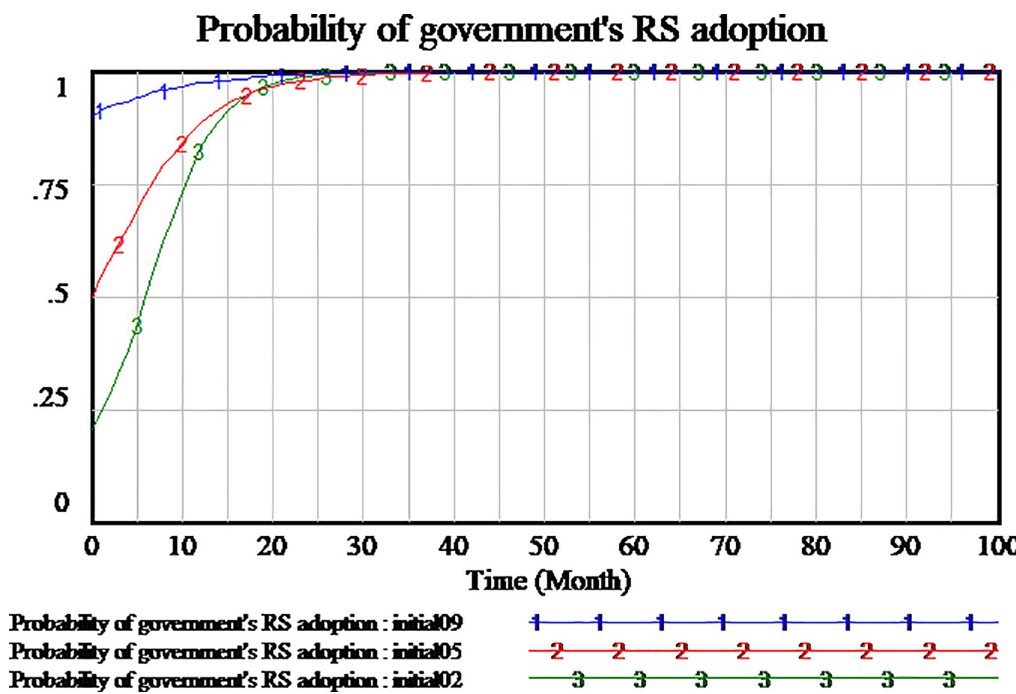
Fig 8. Impact of different initial strategies in government’s strategies adoption.